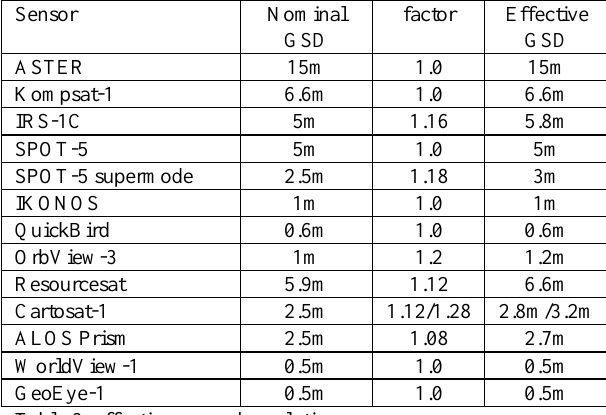
Figure 11. Spectral range of panchromatic channel (upper line in grey) and color channels